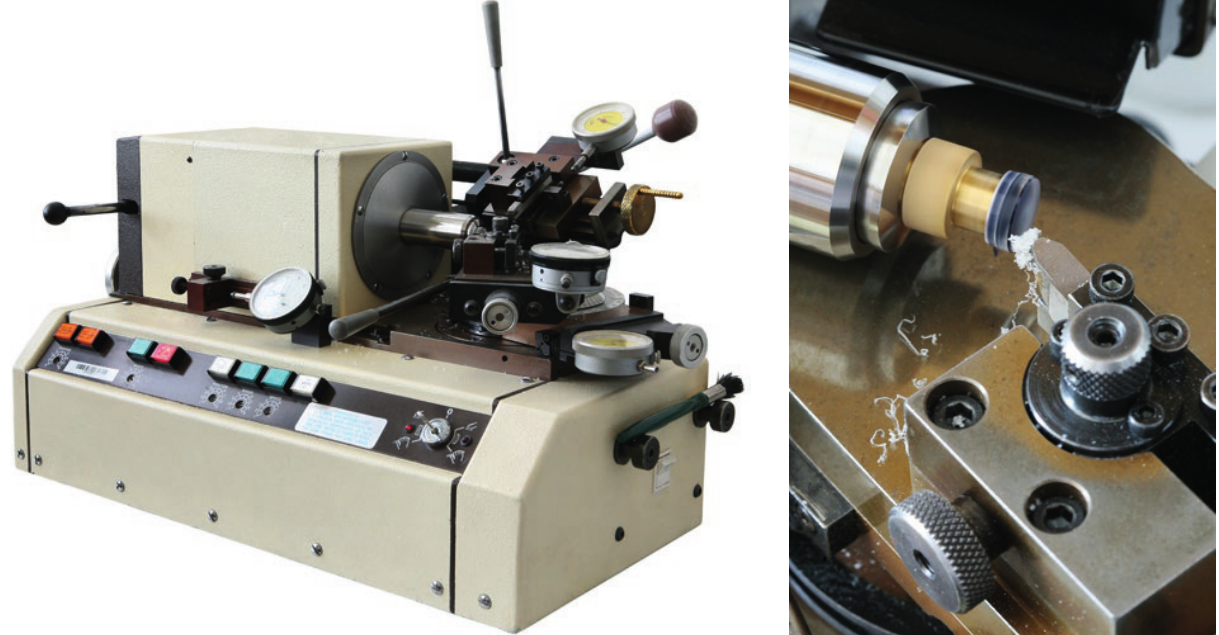
Figure 2. Special lathe for contact lens manufacturing (left) and the lathing of the contact lens from